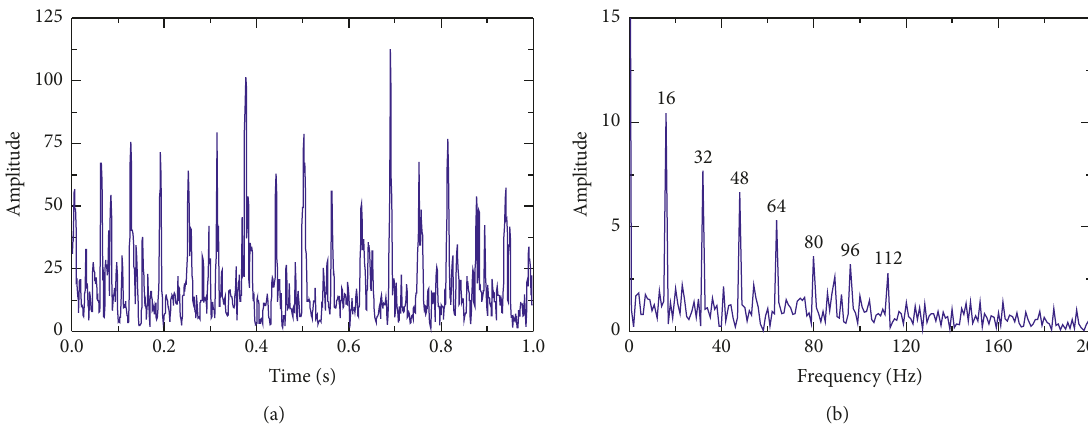
Figure 7: Impulsive extracting results of the proposed MECGMF: (a) waveform; (b) frequency